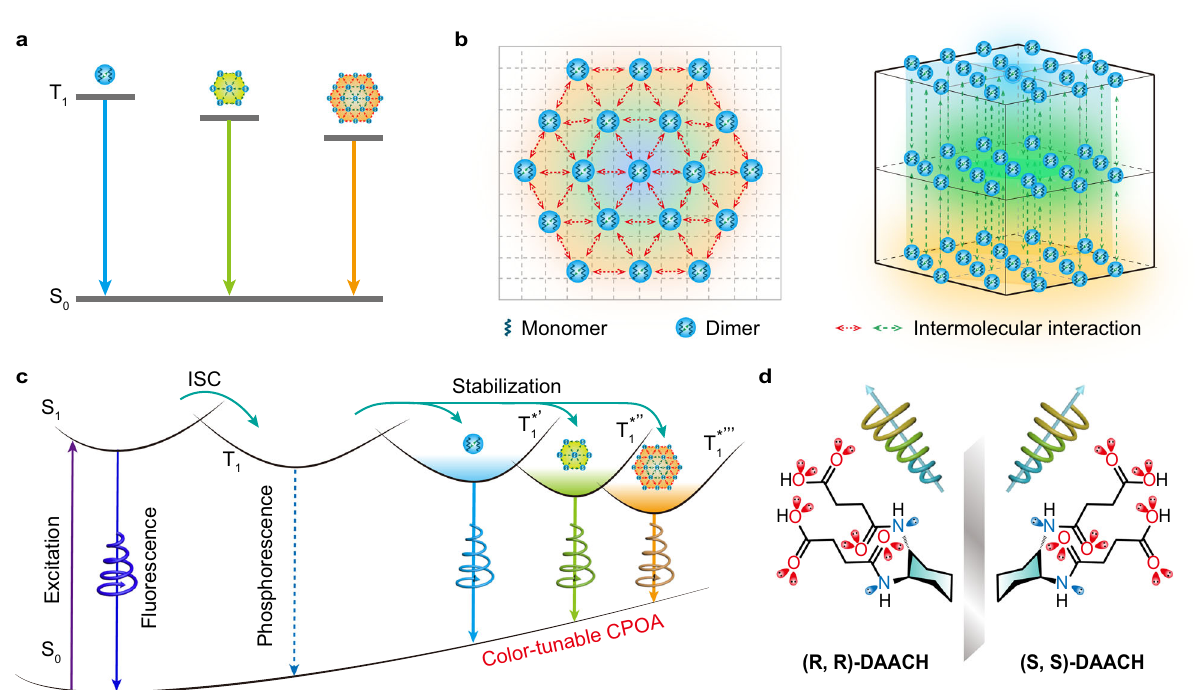
Fig. 1 Molecular design of single-component color-tunable CPOA. a Proposed mechanism of color-tunable phosphorescence emission from different cluster sizes showing tunable excited energy levels. b Top and lateral views of molecular packing in the chiral cluster crystal. The dotted arrows represent intra/intermolecular interactions. The blue ball and the hexagons with different background colors ranging from blue to orange represent size-dependent CTE centers showing color-tunable CPOA. c , d Proposed mechanism ( c ) and molecular design ( d ) of color-tunable CPOA from a single-component chiral cluster crystal. So is the ground state. S 1 and T 1 represent the lowest singlet and triplet excited states. T 1 * ’ , T 1 * ” , and T 1 * ”’ are the stabilized triplet excited states originated from varied emission species showing different cluster sizes,